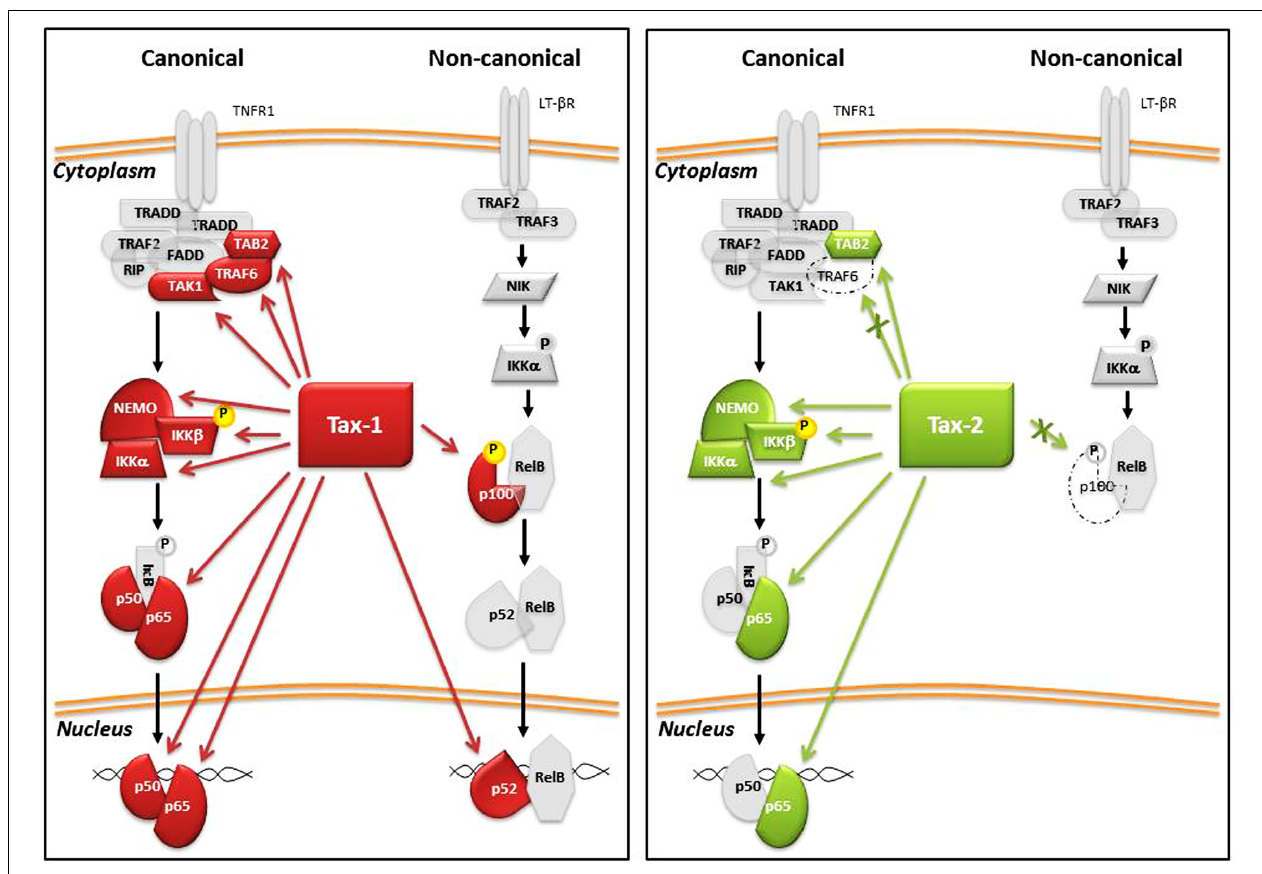
FIGURE 4 |Tax-1 andTax-2 interactions with factors of NF- κ B pathway. Red arrows indicateTax-1 interaction and the green arrows indicateTax-2 interactions. Dashed proteins indicate the absence of interaction